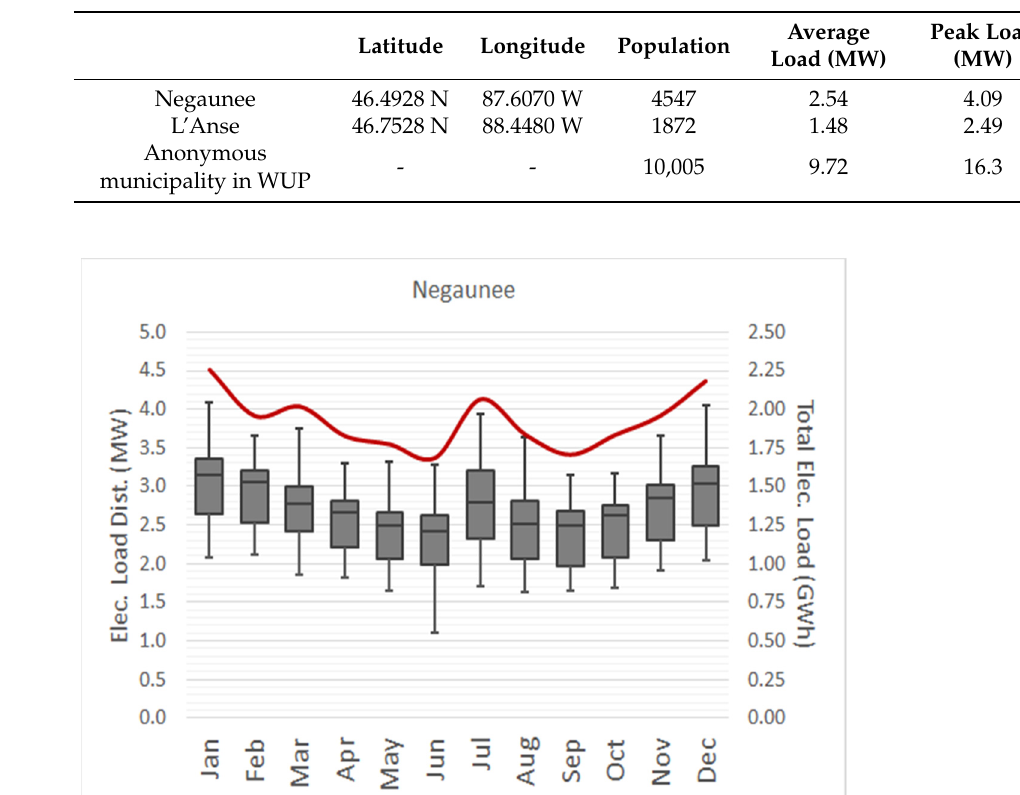
Table 1. Municipalities and energy load descriptions.